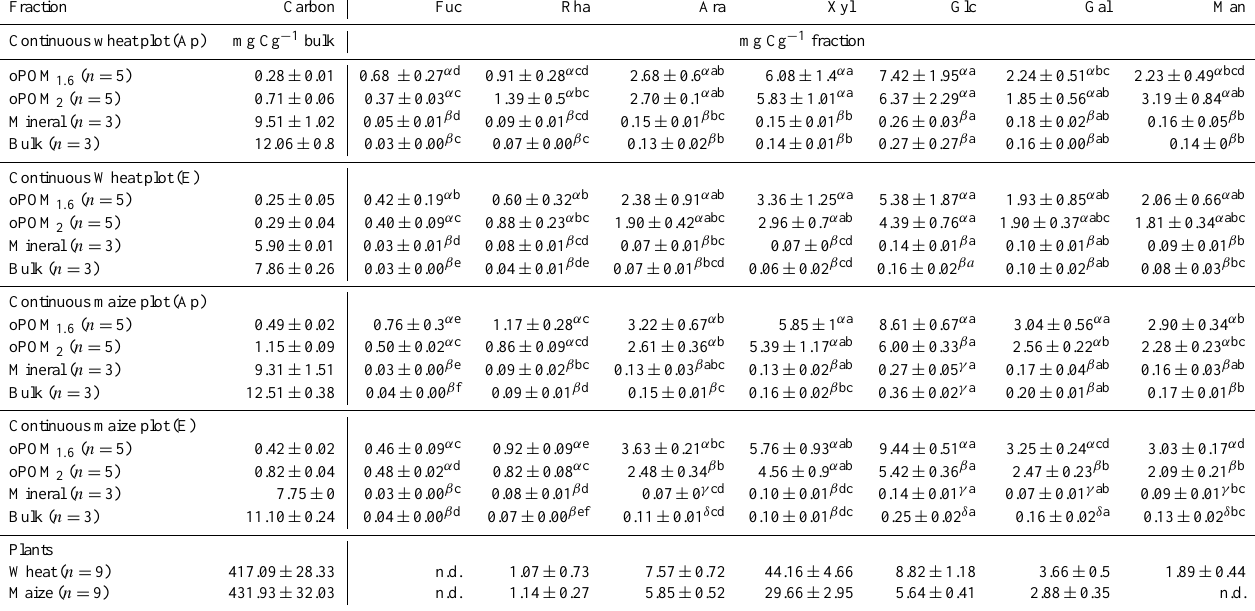
Table 1. Carbon content [mgCg − 1 (dw)] and sugar content [mgCg − 1 (dw)] in bulk soil, soil density fractions and wheat and maize plants. Latin letters (a–e) within one row indicate significant differences ( p <0.05) among the different sugars within one fraction. Greek letters ( α − δ) within one column indicate significant differences among different fractions for individual sugars. Means and standard error.